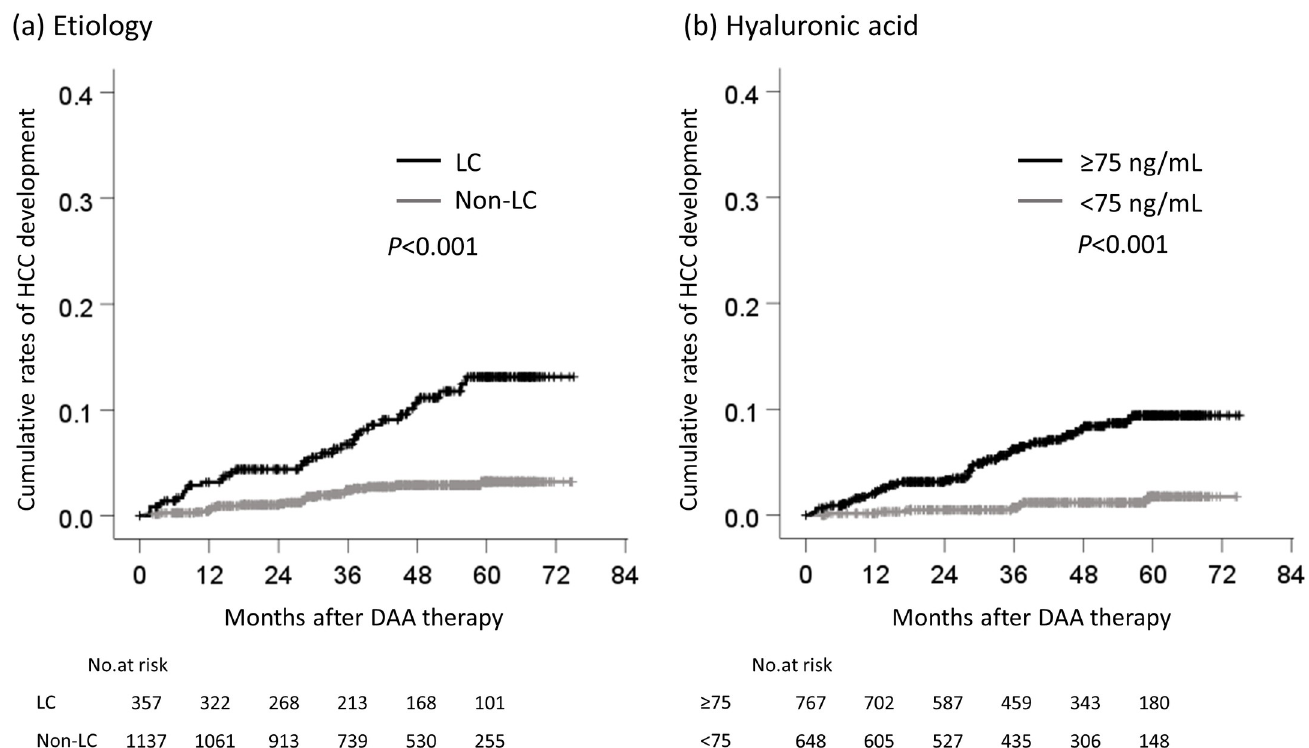
Fig 4. The cumulative rates of HCC development by etiology and hyaluronic acid. (a) between cirrhosis and non-cirrhosis, (b) between HA � 75 ng/mL and < 75 ng/mL. HCC, hepatocellular carcinoma; DAA, direct-acting antiviral; LC, liver cirrhosis; HA, hyaluronic acid.